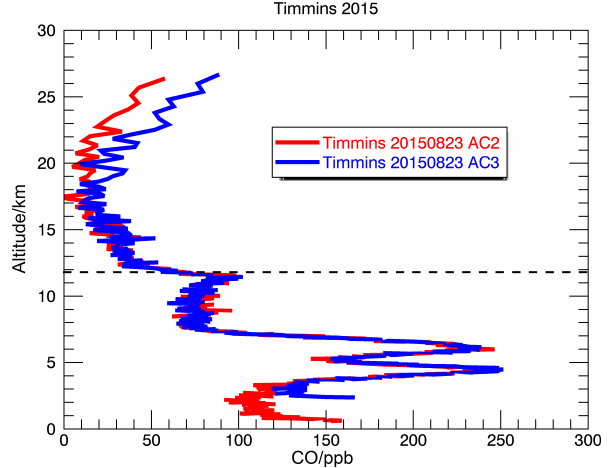
Figure 6. Vertical profiles of CH 4 derived for the flight on 23 Au- gust 2015 from Timmins, Ontario, Canada. Excellent agreement is observed between all AirCores. There is a slight high bias of the light LMD AirCores above 20km with respect to both the Uni- versity of Frankfurt AirCores (red and blue trace) and the high- resolution (HR) AirCore (green trace). The fine structures observed by the HR AirCore are smeared out in the lightweight AirCores by the University of Frankfurt and LMD. The dashed lines represent the thermal tropopause according to the WMO